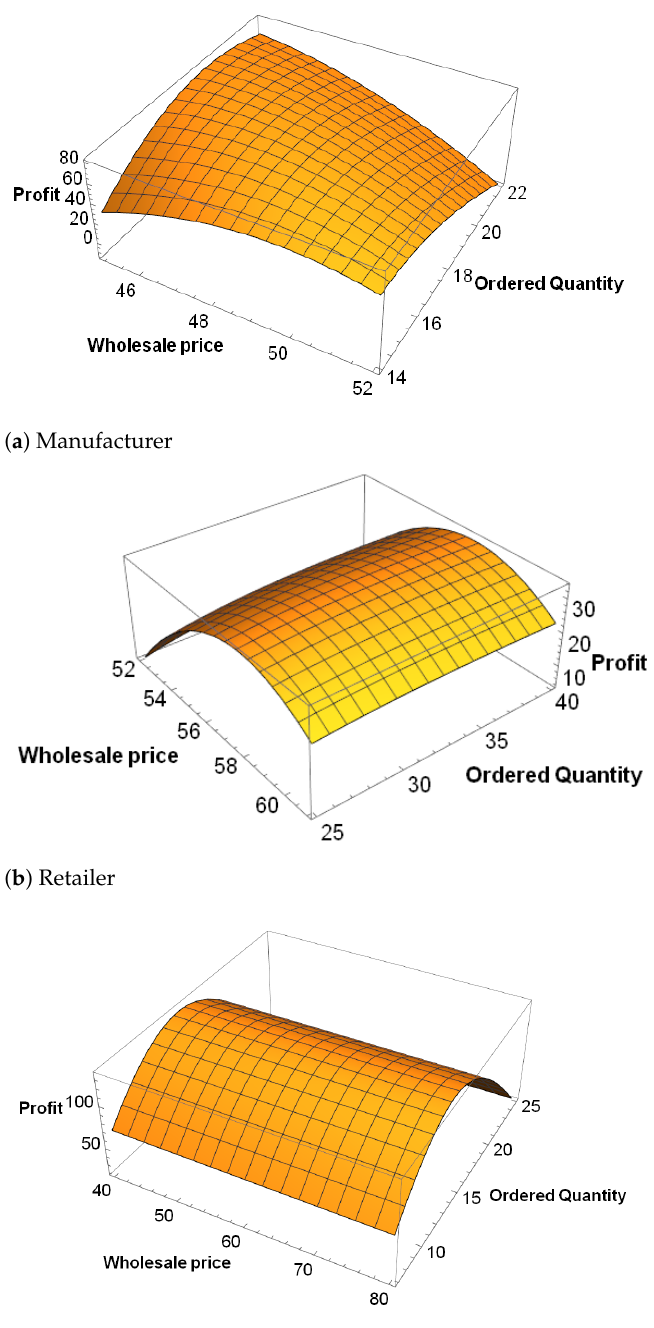
Figure 3. 3D figures showing the comparison of profit with ordered quantity and wholesale